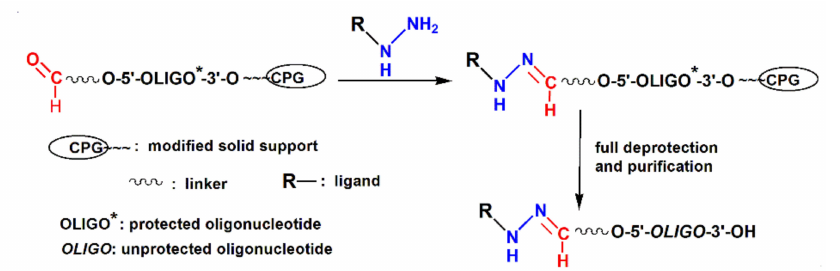
Figure 1. The general scheme of the solid-phase synthesis of 5 (cid:48) -conjugates of oligonucleotides with hydrazone